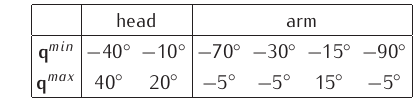
Table 2. Joints limits of the Kobian